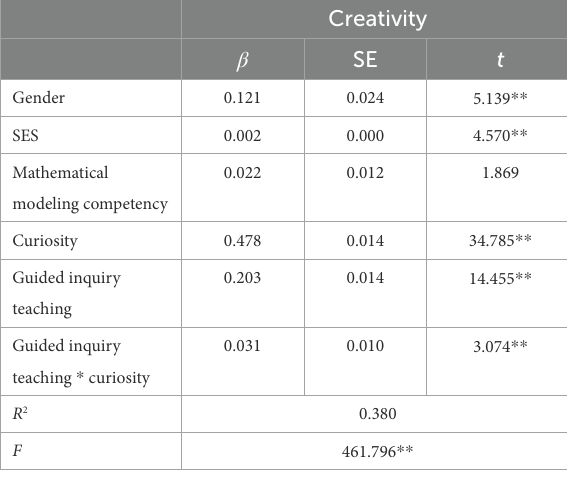
TABLE 2 The moderating effect of guided inquiry teaching.